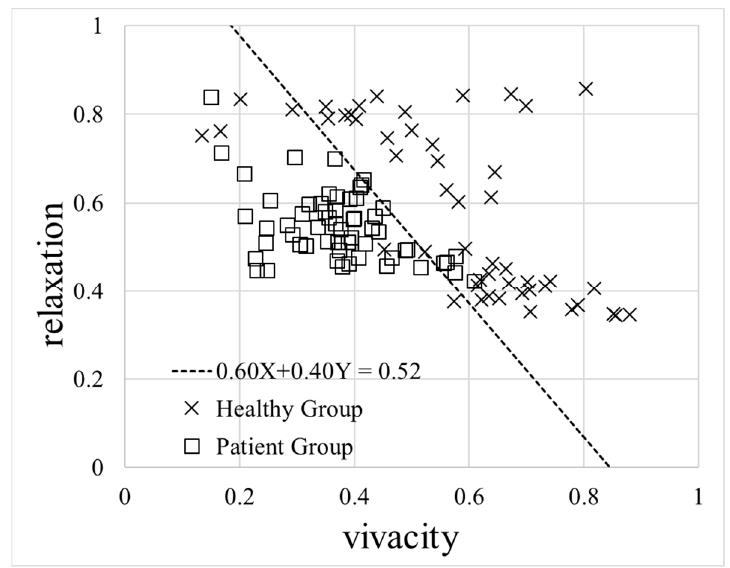
Figure 1. Scatter plot of relaxation and vivacity. Data are plotted for each voice acquisition. There are 50 data for the 13 people in the healthy group and 58 for the 9 people in the patient group. The straight line separates the healthy group from the patient group (0.60X + 0.40Y = 0.52).